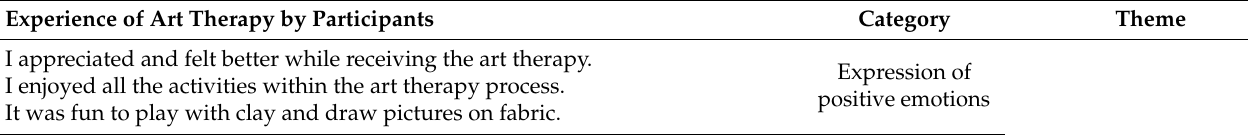
Table 5. Qualitative analysis satisfaction of art